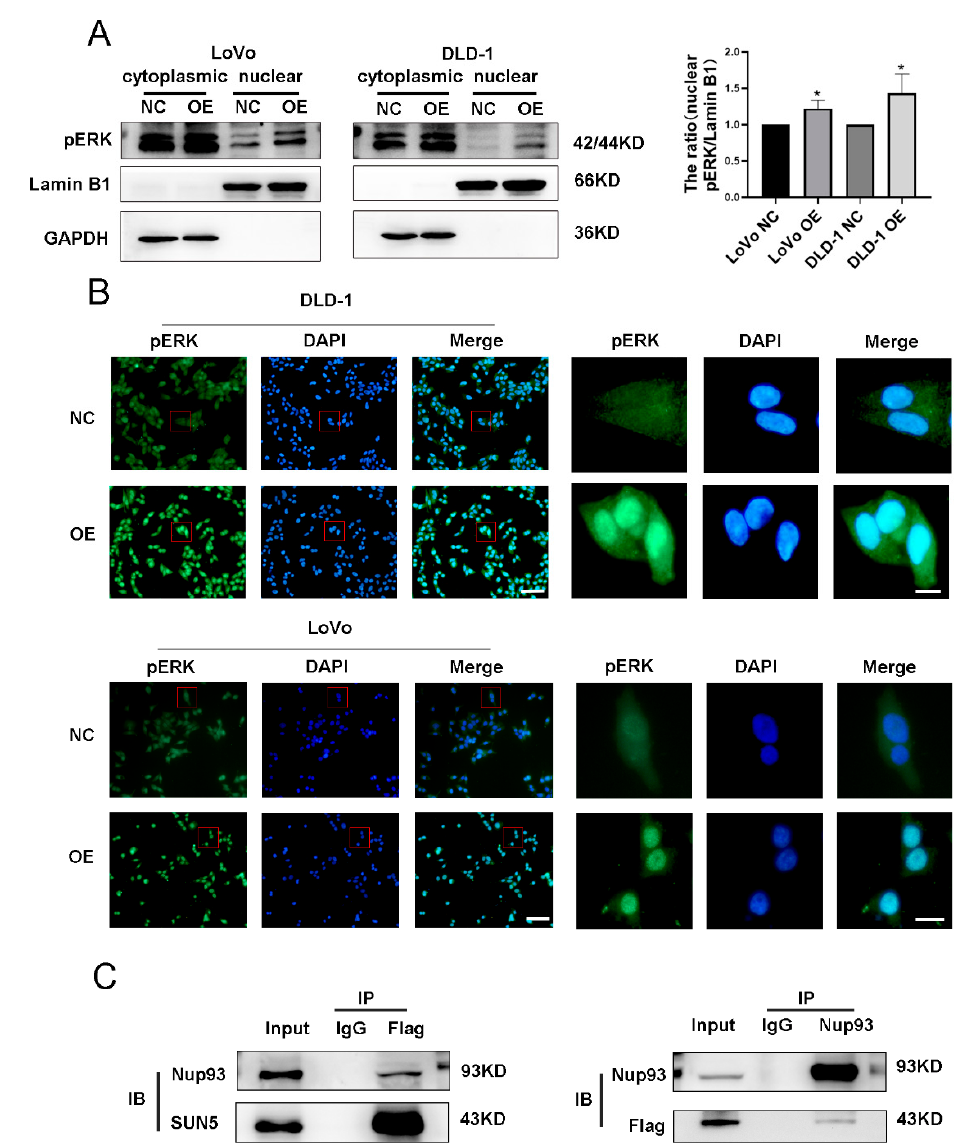
Figure 8. SUN5 interacted with Nup93 to promote phosphorylated ERK1/2 nuclear translocation. ( A ) The expression of pERK1/2 was assessed in SUN5-OE and NC cells by Western blotting. GAPDH and LaminB1 were used as controls for cytoplasmic and nucleus fractional purity, respectively (* p < 0.05). ( B ) The expression and subcellular localization of pERK (green) were determined by immunofluorescence staining. DAPI was used for nuclear staining (blue). Scale bar: 50 µ m (left); 5 µ m (right). ( C ) The interaction between SUN5 and Nup93 was validated in SUN5-OE cells by Co-IP analysis.